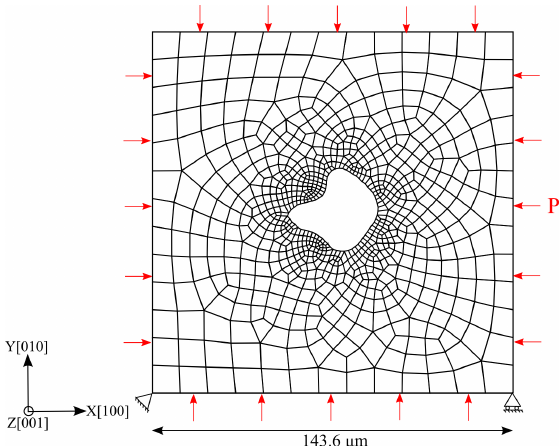
Figure 12. Quasi-2D representative CPFE model with finite element mesh and boundary conditions for the irregular shaped void. ‘P’ represents the isostatic pressure applied on the outer boundaries.